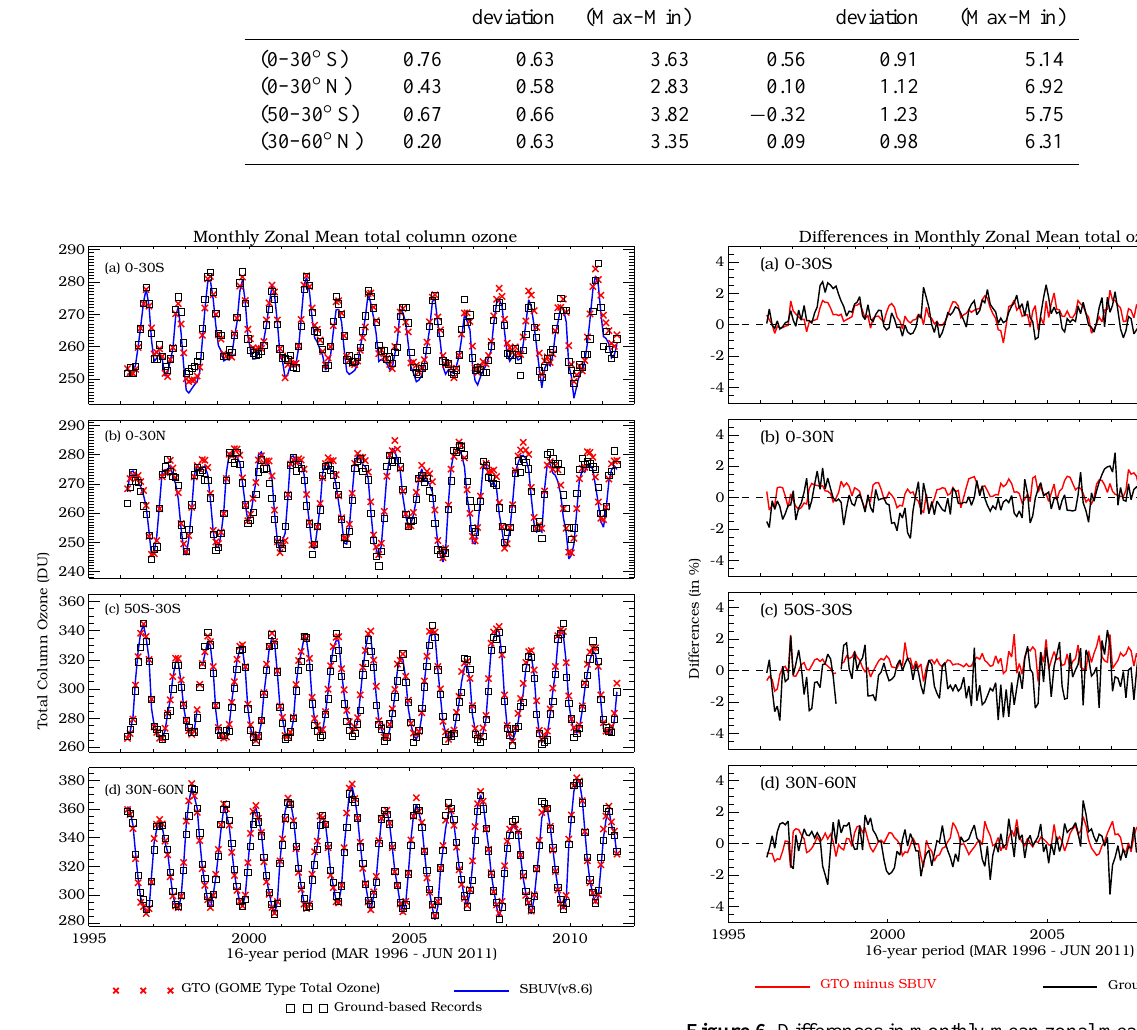
Figure 5. Monthly mean zonal mean total ozone (area-weighted zonal means for broader latitudinal zones).